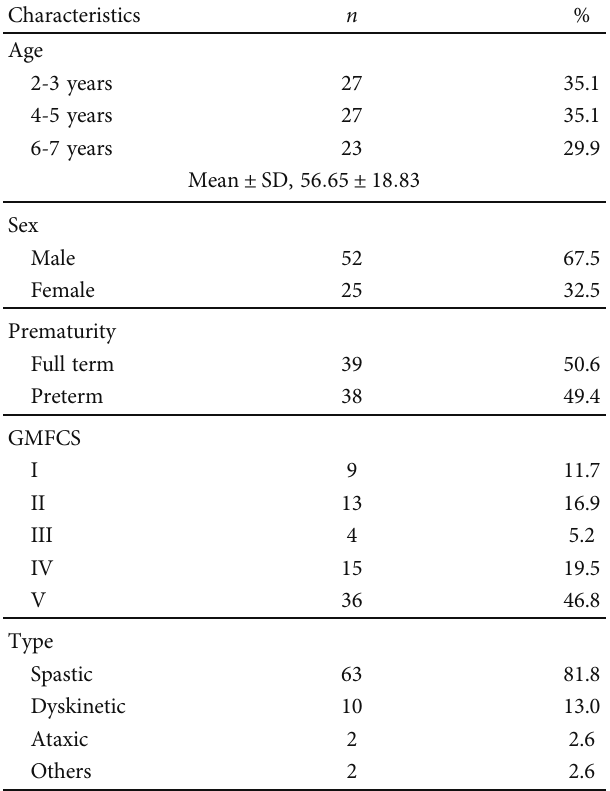
Table 3: General information of the participants.